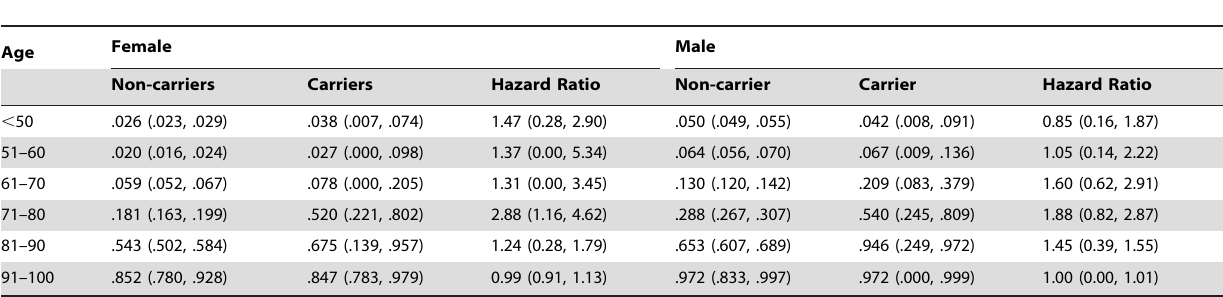
Table 3. Estimated hazard of mortality due to carrying a BRCA mutation in the absence of any cancer 1 .